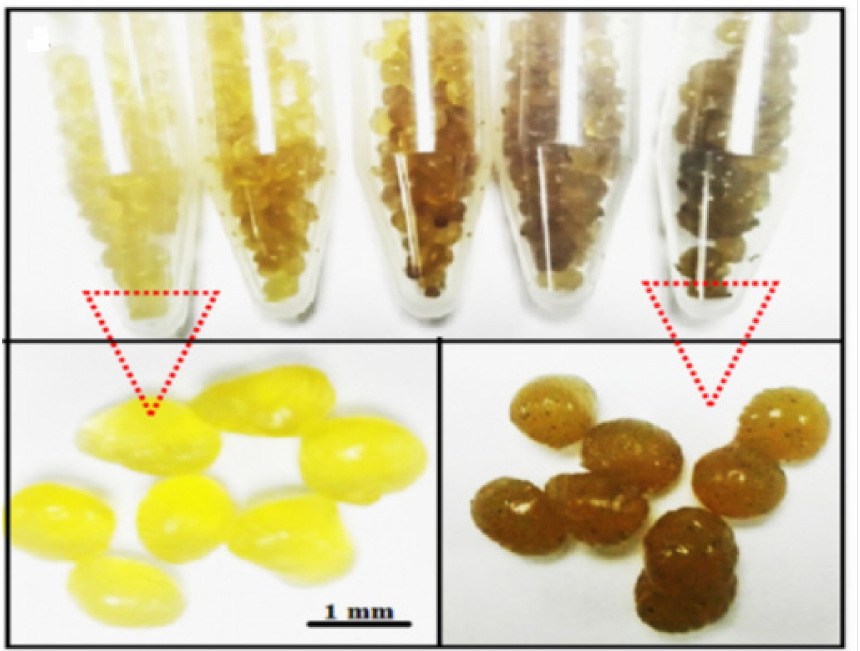
Figure 7. Digital image of Kappa-Carrageenan/Ag bio-nano composite with the various ratios of Ag-NPs (adapted with permission from reference [61]).